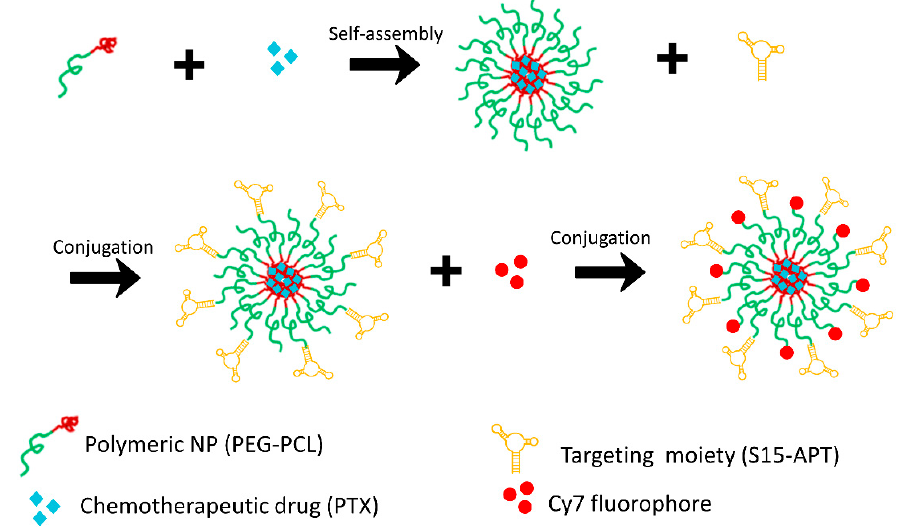
Figure 1. Schematic structure of the Cy7-labeled APT-NPs and their preparation steps.